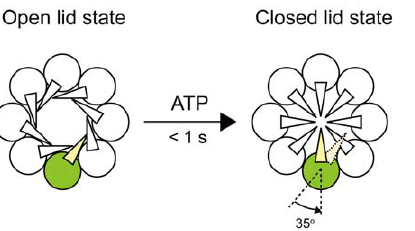
Figure 5. Conformational change of T . KS-1 a chaperonin subunits. ATP induces the conformational change from the open lid to the closed lid state, which is responsible for a approximately 35 u counterclockwise rotation of the helical protrusion.